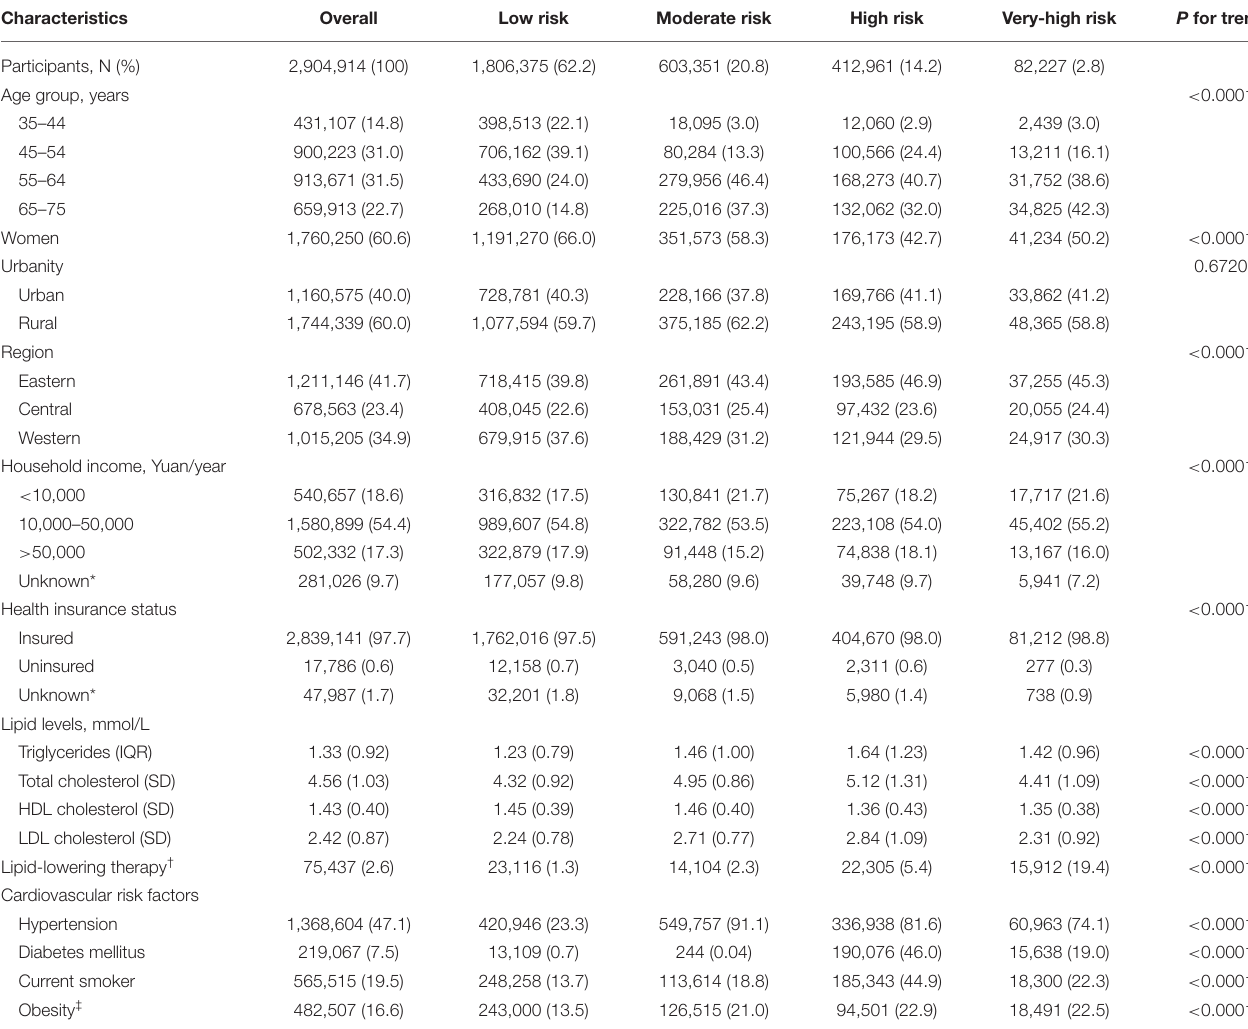
TABLE 1 | Characteristics of the study population by 10-year ASCVD risk stratifications. Characteristics Overall Low risk Moderate risk High risk Very-high risk P for